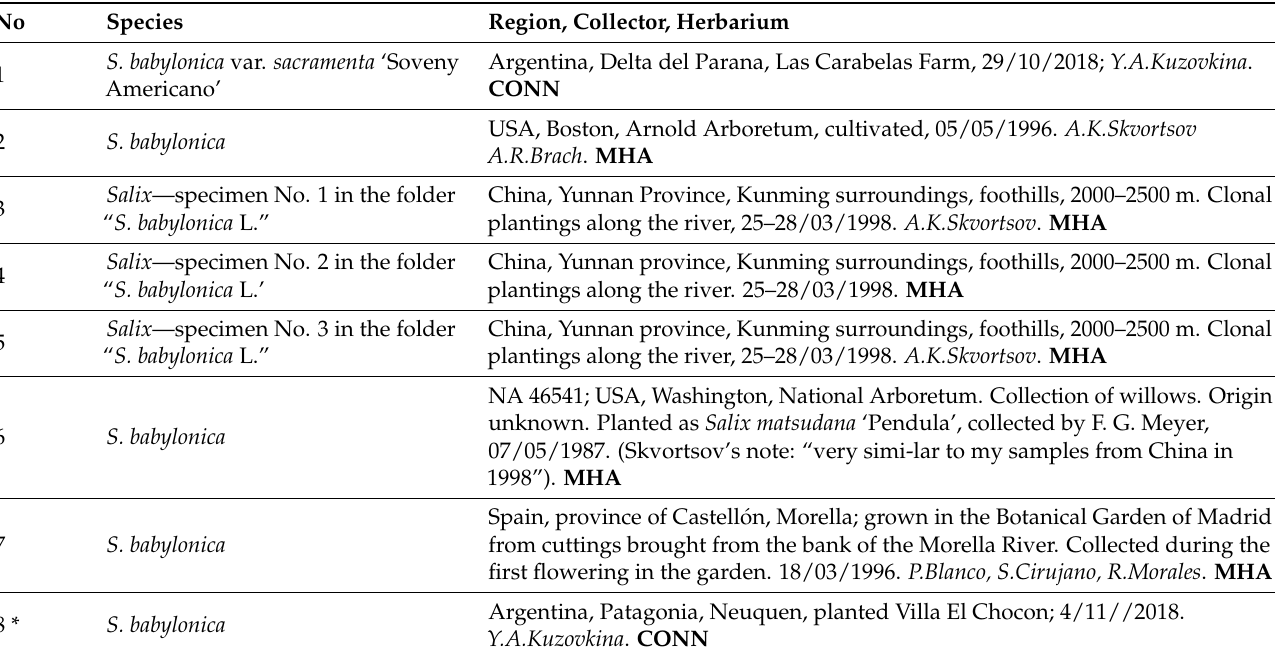
Table A1. Specimen information for S. babylonica used in the present study. The Herbaria where the specimens are kept indicated in bold. The specimen number corresponds to the specimen number in Table 1. The specimen number with asterisk (*) means the live